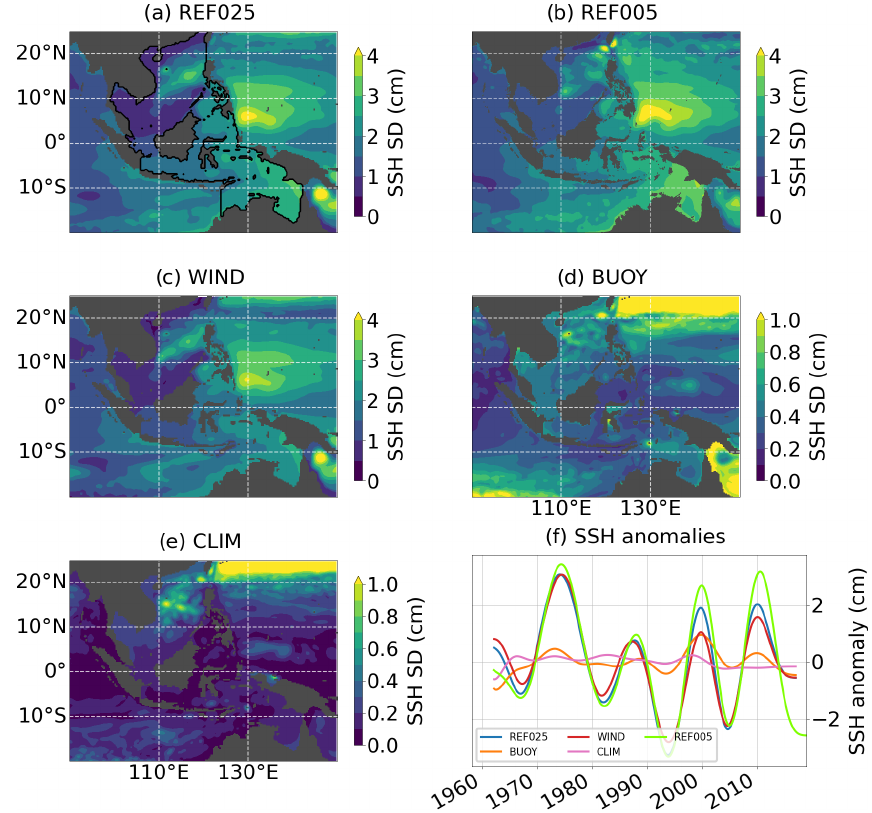
Figure 4. SD of low-pass-filtered SSH time series (8 years) from (a) REF025, (b) REF005, (c) WIND, (d) BUOY, and (e) CLIM as well as (f) low-pass-filtered SSH anomalies averaged over black contour lines shown in panel (a) . Note the different colour bars.